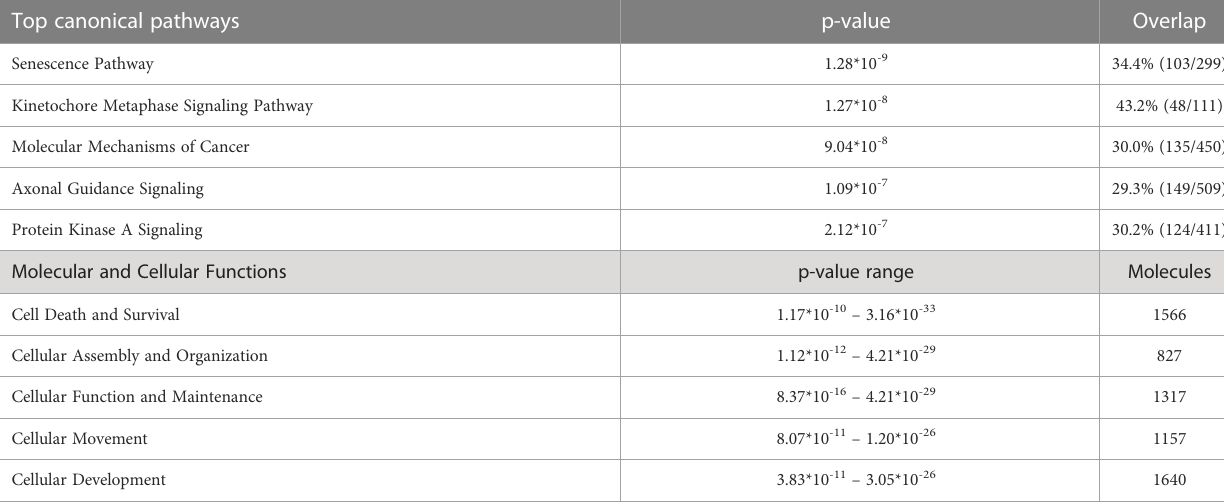
TABLE 2 Top canonical pathways and top molecular and cellular functions predicted for the differentially expressed genes from the RNA sequencing data using Ingenuity Pathway Analysis (IPA). Top canonical